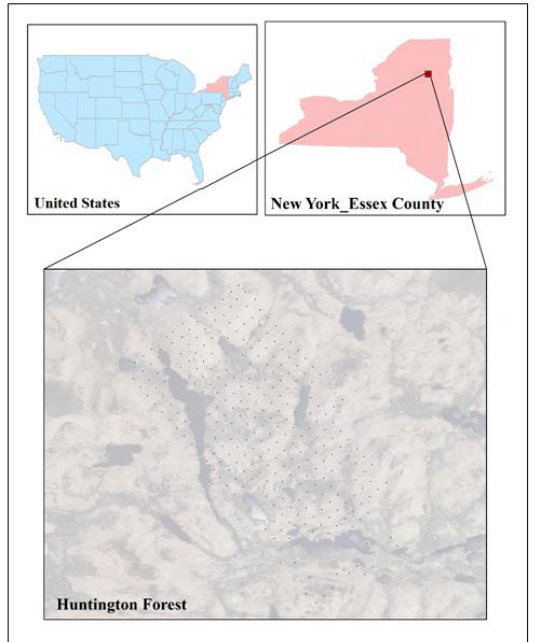
Figure 1 . Location of the study area (Huntington Wildlife Forest) in Essex County, NY for forest AGB estimation using decision-tree based models. Black circles indicate sample plots located in Huntington wildlife